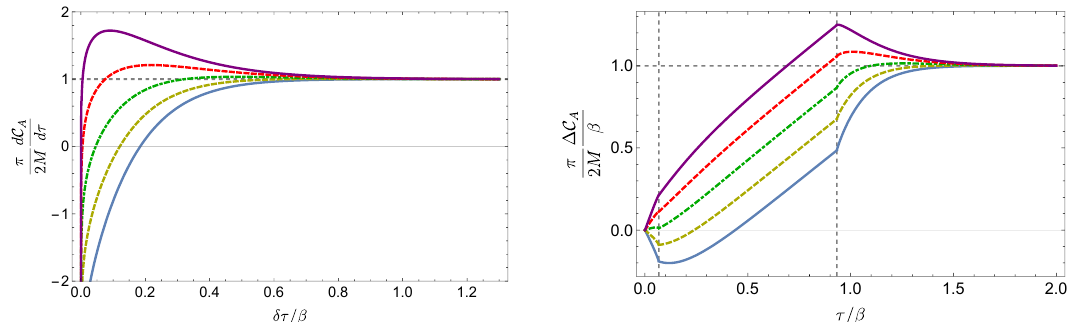
Figure 30 . The rate of change of the complexity (left) and its average value (right) as a function of time for spherical black holes ( k = 1) in d = 4 with r h = 2 L for di(cid:11)erent values of the constant a 0 | a 0 = (cid:0) 4 (blue, solid), a 0 = (cid:0) 2 (yellow, dashed), a 0 = 0 (green, dot-dashed), a 0 = 2 (red, dashed) and a 0 = 4 (purple, solid). We have set (cid:11) = L=R for